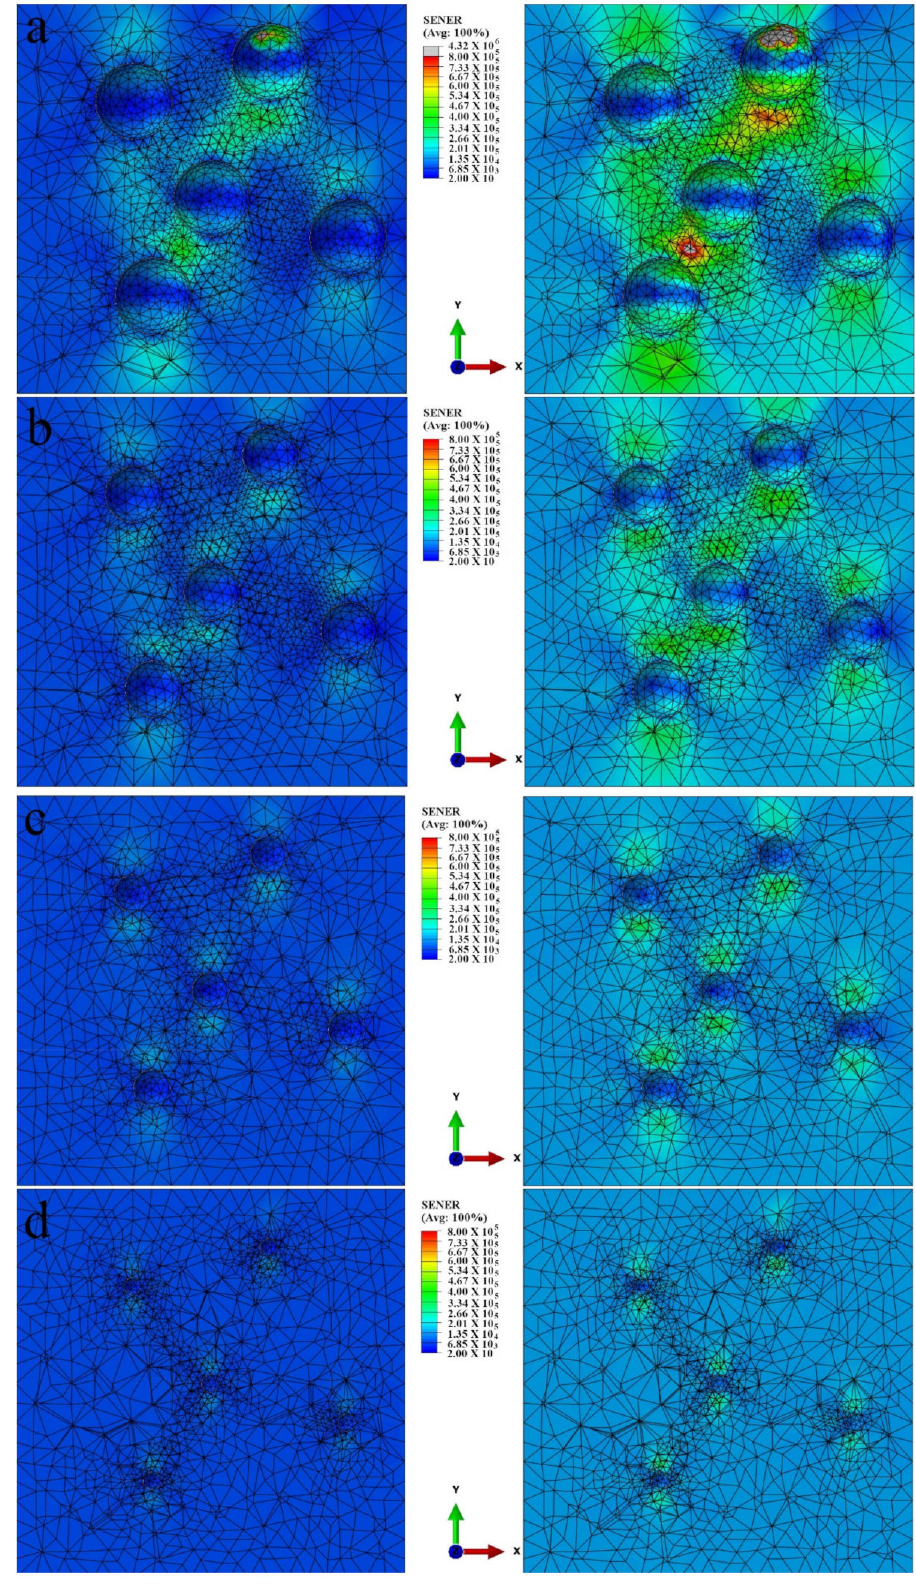
Figure 9. Contour plots of strain energy density distributions in the uniaxial specimen for model NR/BR composites filled with different particle size with diameter of ( a ) r = 0.4 mm, ( b ) r = 0.3 mm, ( c ) r = 0.2 mm, ( d ) r = 0.1 mm, at different strain level from 25% to